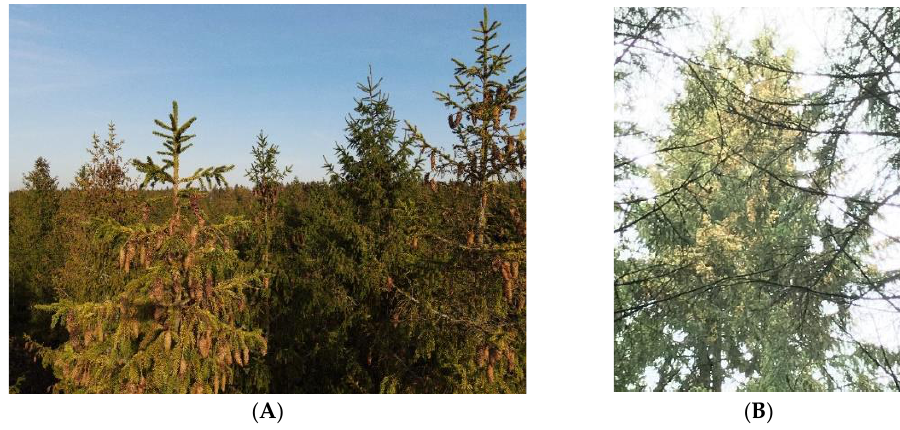
Figure 5. ( A ) Example of tree crowns full of cones and ( B ) example of spruce flowering in spring.